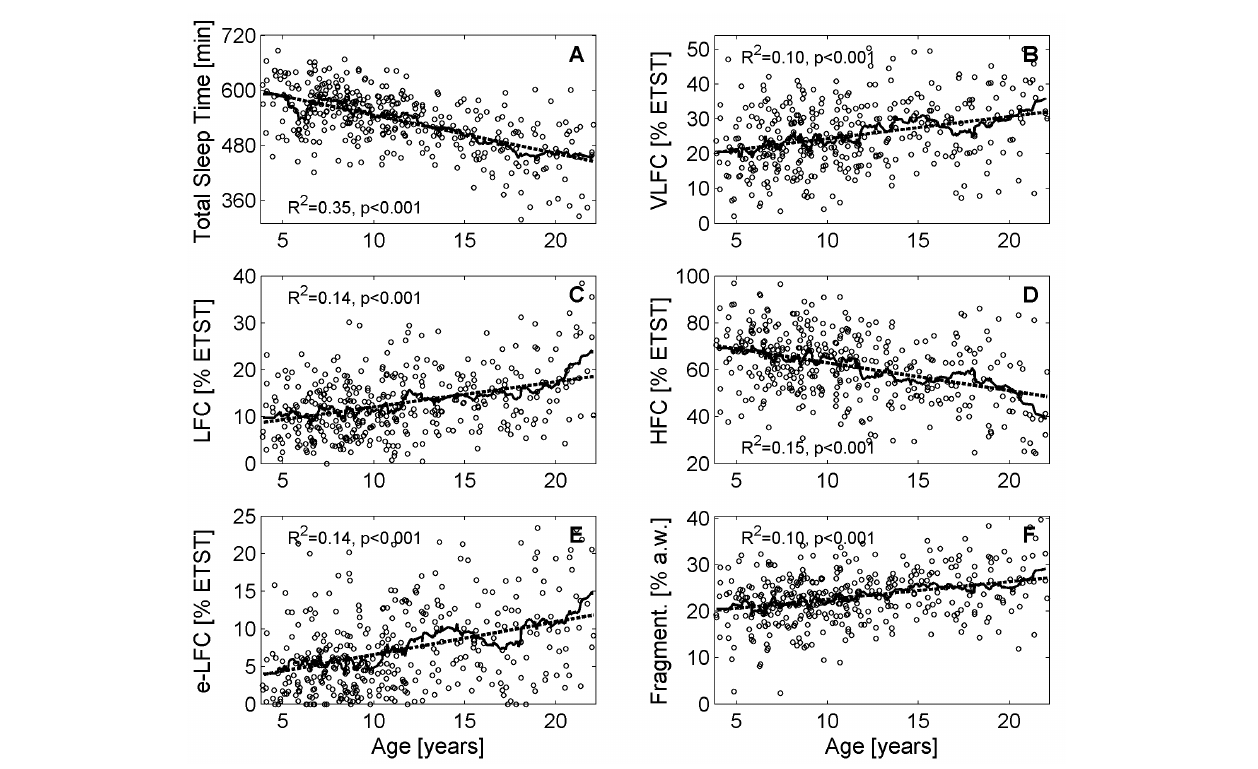
FIGURE 1 | Variations of cardiopulmonary coupling (CPC) parameters during childhood and adolescence. (A) Estimated total sleep time (ETST), (B) Very low frequency coupling (VLFC) indicating REM/wake states, (C) Low frequency coupling (LFC) indicating unstable non-REM sleep, i.e., cyclic alternating pattern (CAP) sleep, (D) High frequency coupling (HFC) indicating stable non-REM sleep, i.e., non-CAP sleep, (E) Elevated low frequency coupling (e-LFC) indicating disordered breathing, and (F) fragmentation of sleep. The solid lines show the moving average (21 consecutive data points) and the dashed line indicates the linear regression